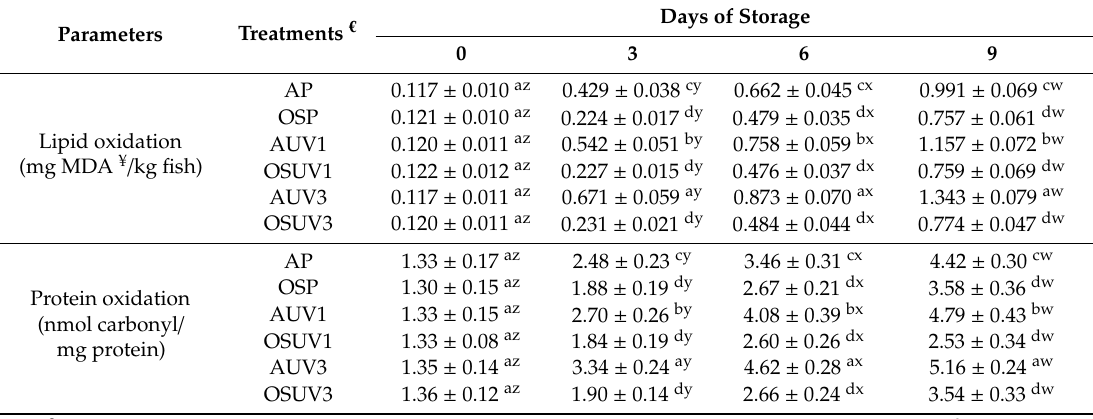
Table 2. Oxidative stability of rainbow trout ( Oncorhynchus mykiss ) fillets non- and treated with oxygen scavenger packaging (OSP) and ultraviolet radiation (UV-C) stored at 4 ± 1 ◦ C for 9